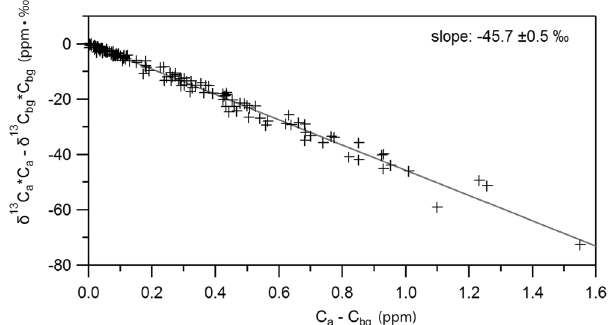
Figure 4. Miller-Tans plot based on all the isotopic values measured and the background value for each diurnal.